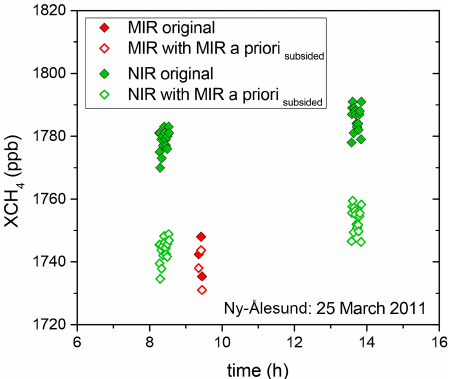
Figure C1. Same as Fig. 4 but MIR and NIR retrievals as computed with their standard (original) retrieval a priori profiles (filled squares) and as corrected to a strongly subsided MIR a priori profile (open squares) as shown in Fig. 3a.